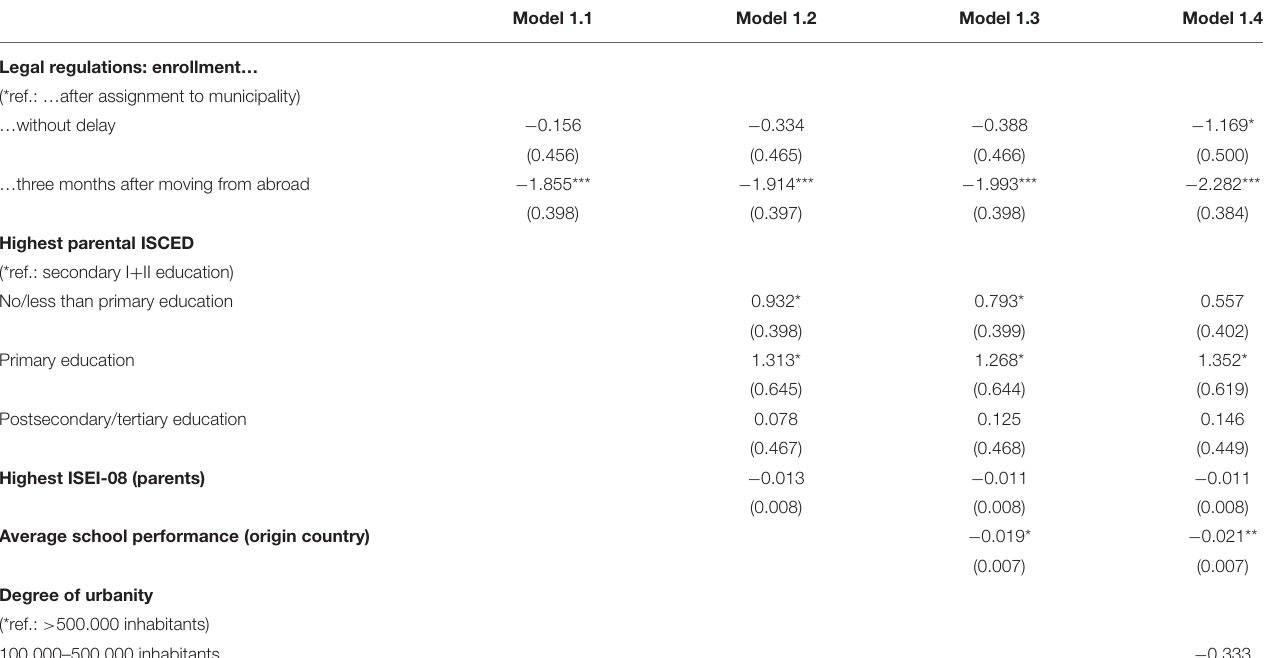
TABLE 6 | Stepwise OLS regression on duration until school enrollment as dependent